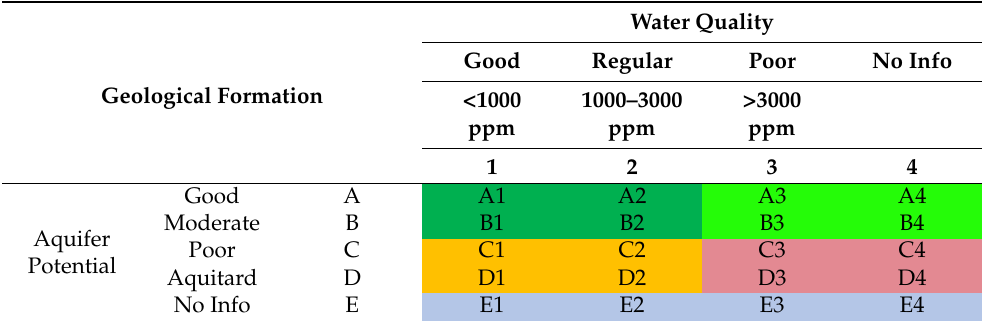
Water Quality Good Regular Poor No Info <1000 1000–3000 ppm ppm